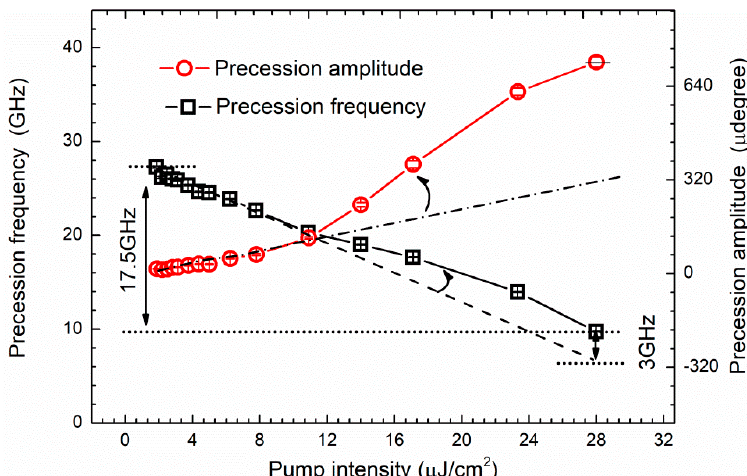
Figure 2. (Color online) Precession frequency and precession amplitude as a function of pump intensity for the annealed sample, obtained with linearly-polarized 1.58 eV pump beam at 10 K. No external magnetic field was applied. Pump intensity was varied from 1.8 µ J/cm 2 to 28 µ J/cm 2 . The extended grey dashed line and grey dash-dotted are drawn to clearly show the nonlinear dependence of both the precession frequency and the amplitude on pump intensity.